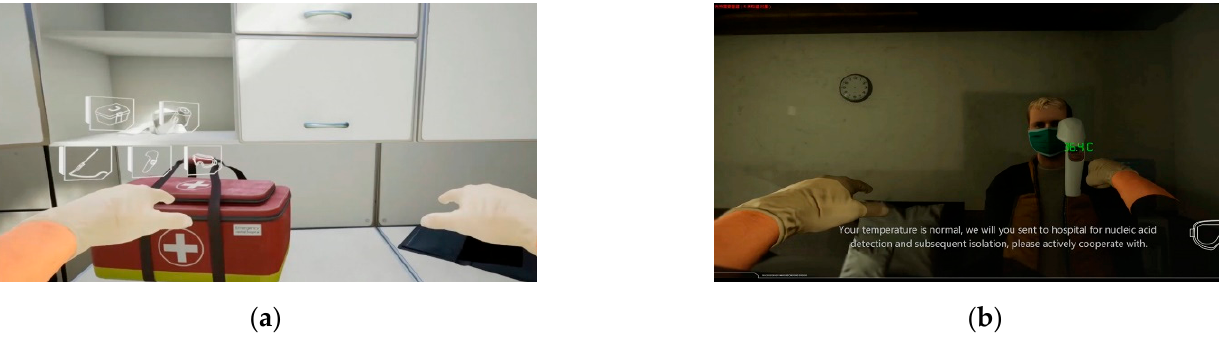
Figure 4. Interactive Methodologies: ( a ) How to interactive will medical package [9]; ( b ) How to use medical tool in on-site investigation [9].